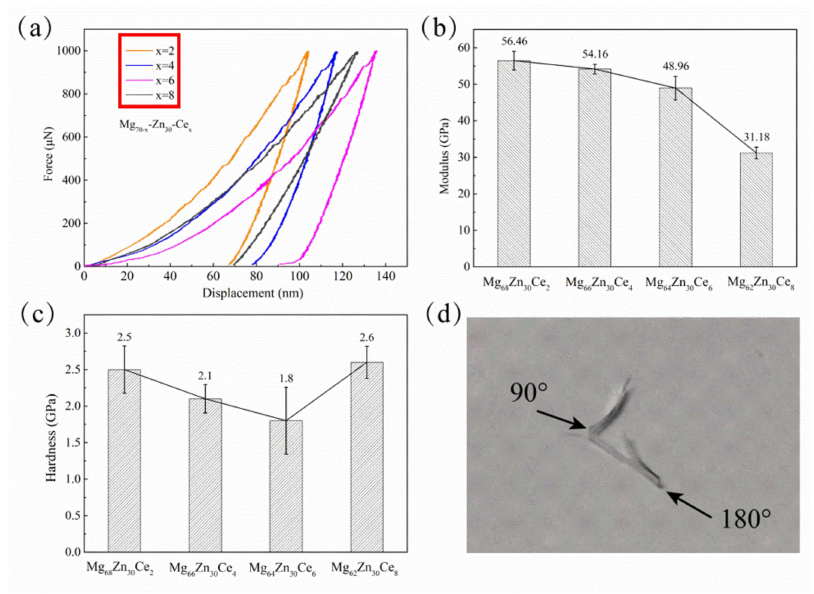
Figure 2. ( a ) Nanoindentation curves of the four samples, ( b ) elastic modulus of the four samples, ( c ) microhardness of the four samples, ( d ) optical image of the bent Ce 2